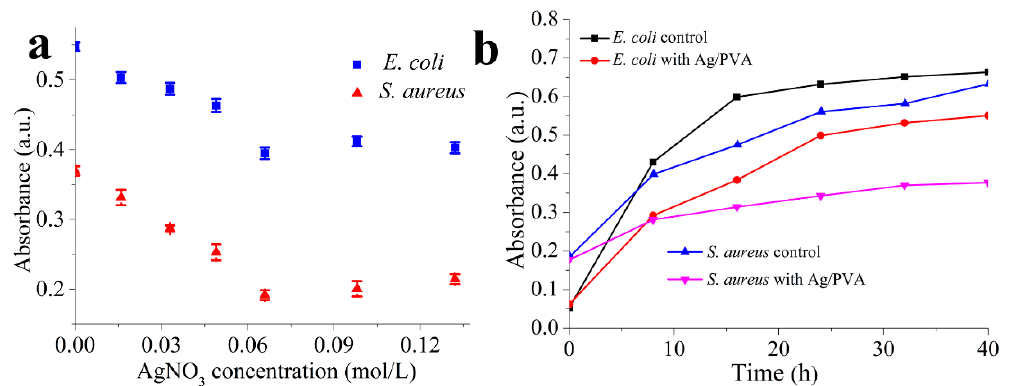
Figure 6. ( a ) Variation relationship between UV-vis absorbance and different concentrations of AgNO 3 for Ag/PVA CNFs, ( b ) bacteria-growth curves of E. coli and S. aureus with and without Ag/PVA CNFs treatment.